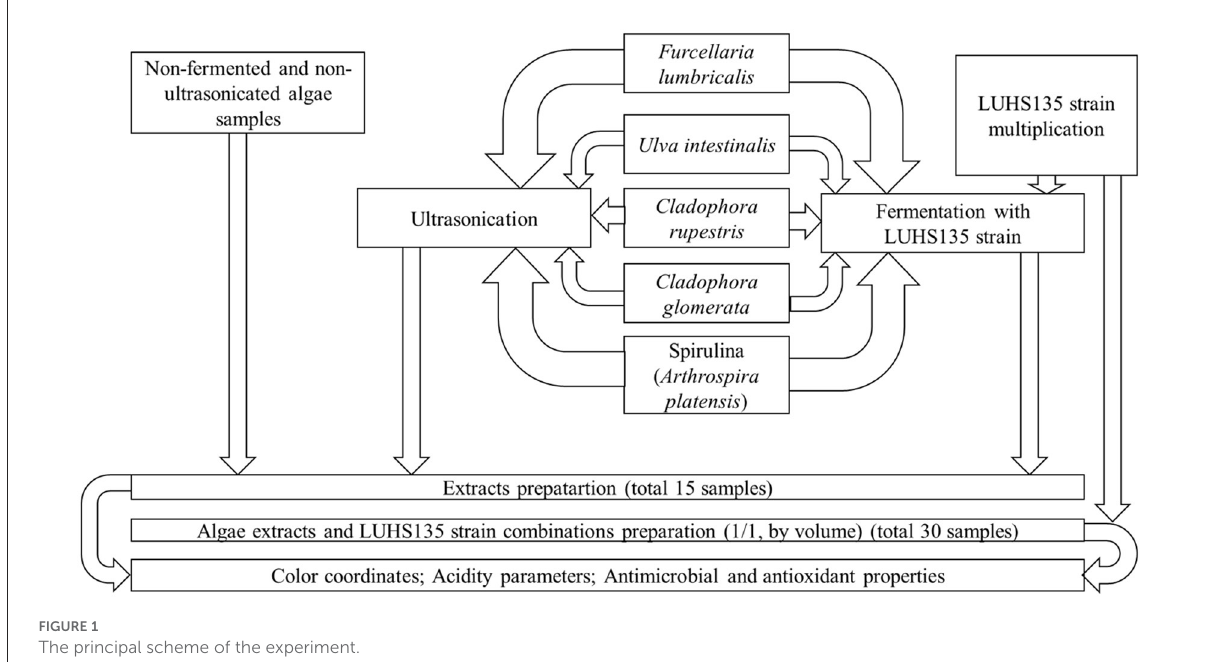
FIGURE1 The principal scheme of the